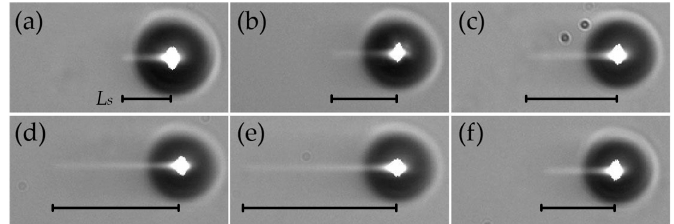
Figure 9. The smear length of water sample 1 L s at five experimental sheath flow rates of ( a ) 25.5 µL/s, ( b ) 38.2 µL/s, ( c ) 51.0 µL/s, ( d ) 76.5 µL/s, ( e ) 102 µL/s and ( f ) the optimised flow rate of 41.0 µL/s. The sample flow rate is 1.42 µL/s.